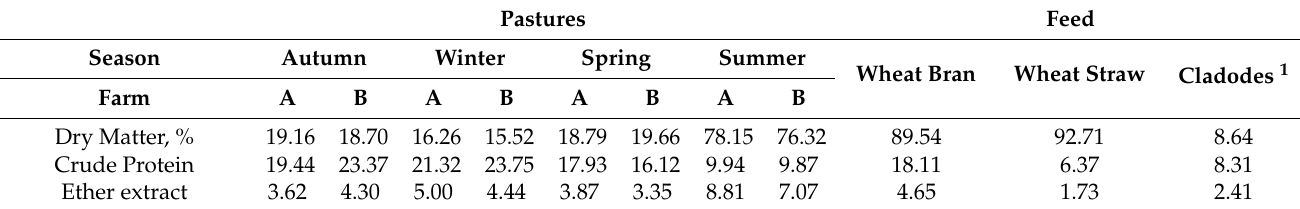
Table 2. Chemical composition (% DM) and fatty acids profile (g/100 g FA) of the ingested fraction of grazing pastures and feeds provided